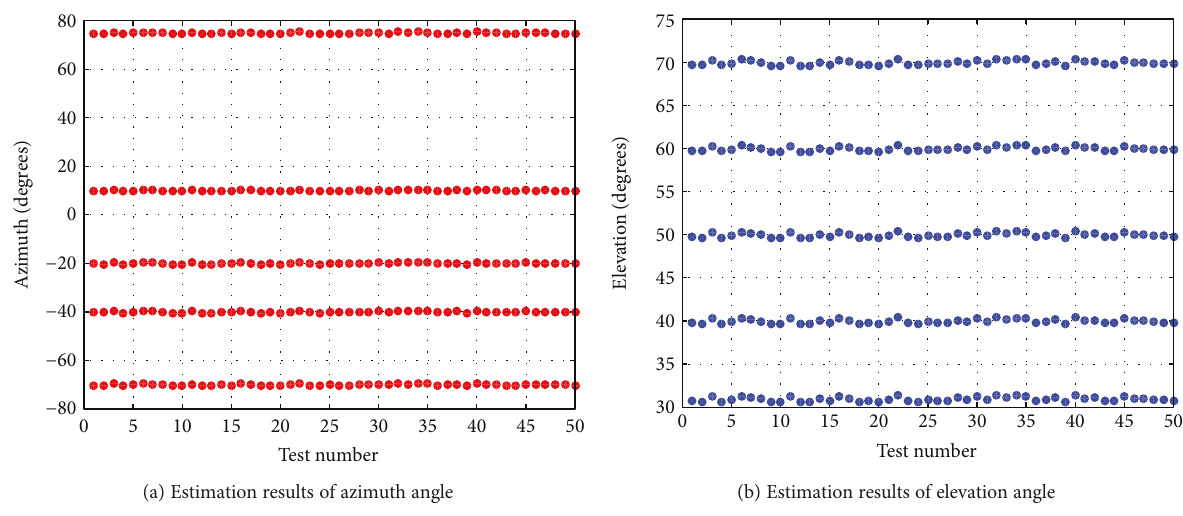
Figure 6: Estimation results of DOA with 10dB using 64 × 4 con fi guration.